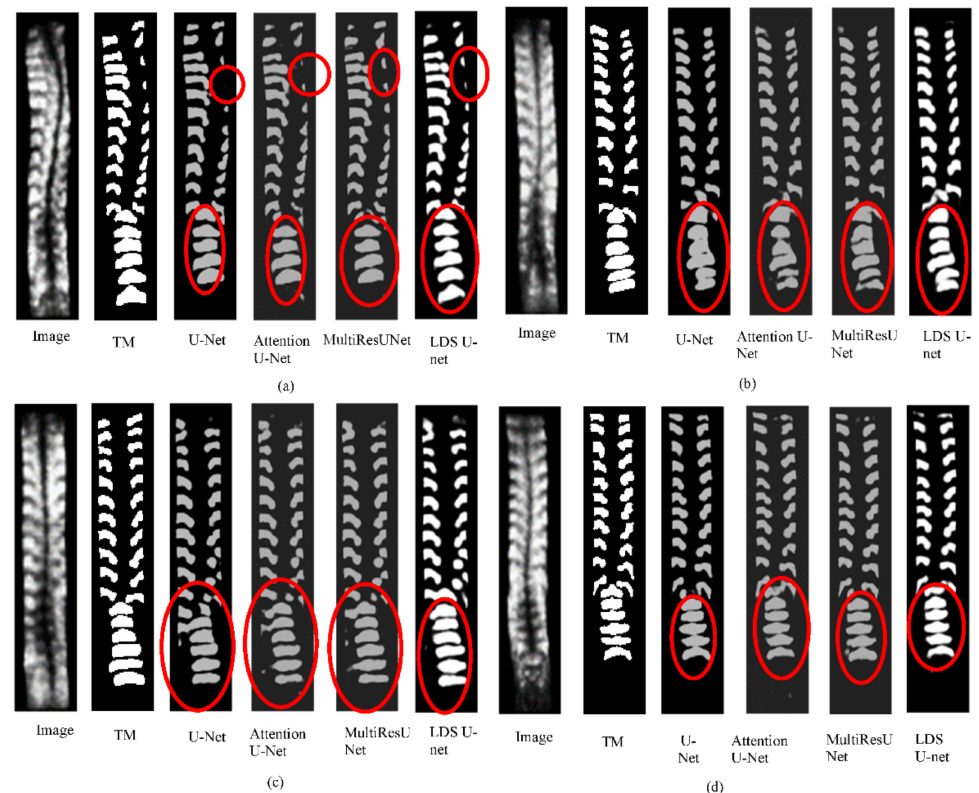
Figure 13. Four spine image sets ( a – d ) consisting of the input image, truth mask, and segmentation results using U-Net, Attention U-Net, MultiResUNet, and the proposed LDS U-Net